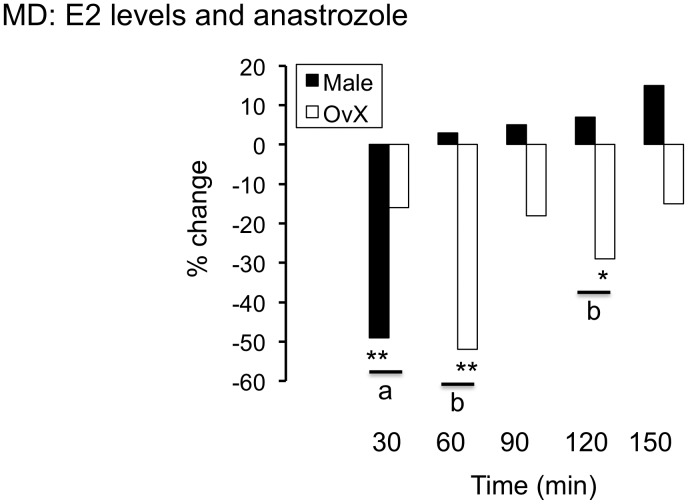
Reverse dialysis of the non-steroidal ARO inhibitor, anastrozole (100 μm, 50 μl) through probes positioned in the Vc and simultaneously topical application on the dorsal Vc surface caused a transient decrease in E2 levels in male and OvX female rats; ∗∗p < 0.01 and ∗p < 0.05 versus pre drug, a = p < 0.05 and b = p < 0.01 versus male.